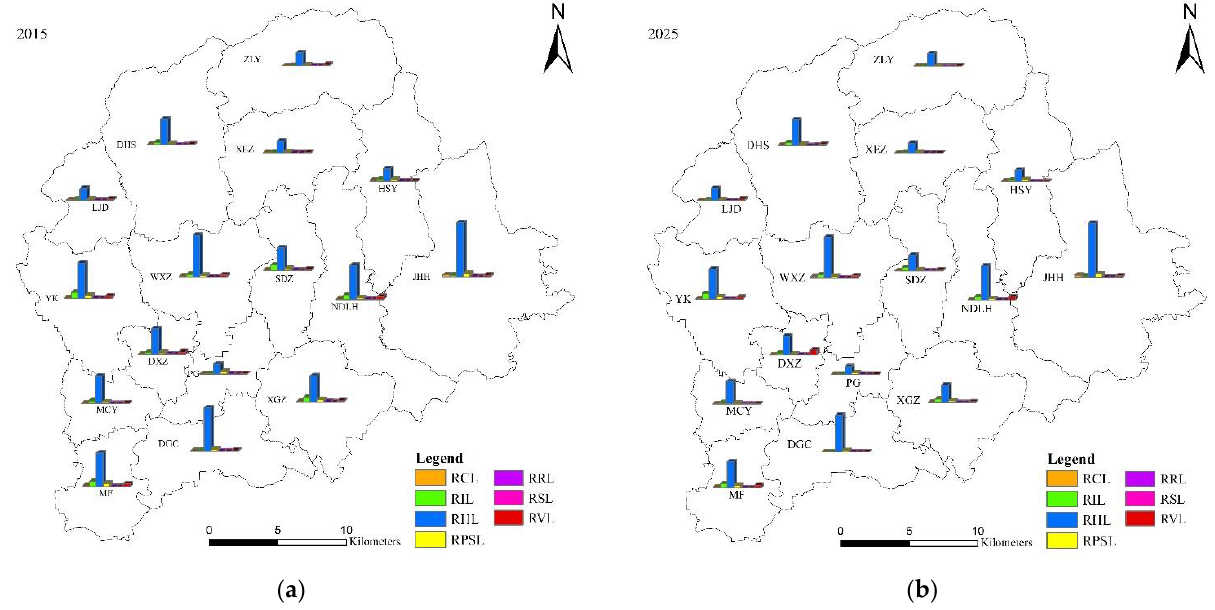
Figure 7. Changes in the RSILUS in Pinggu District from 2015 to 2025. ( a ). The RSILUS in Pinggu District in 2015. ( b ). The RSILUS in Pinggu District in 2025.